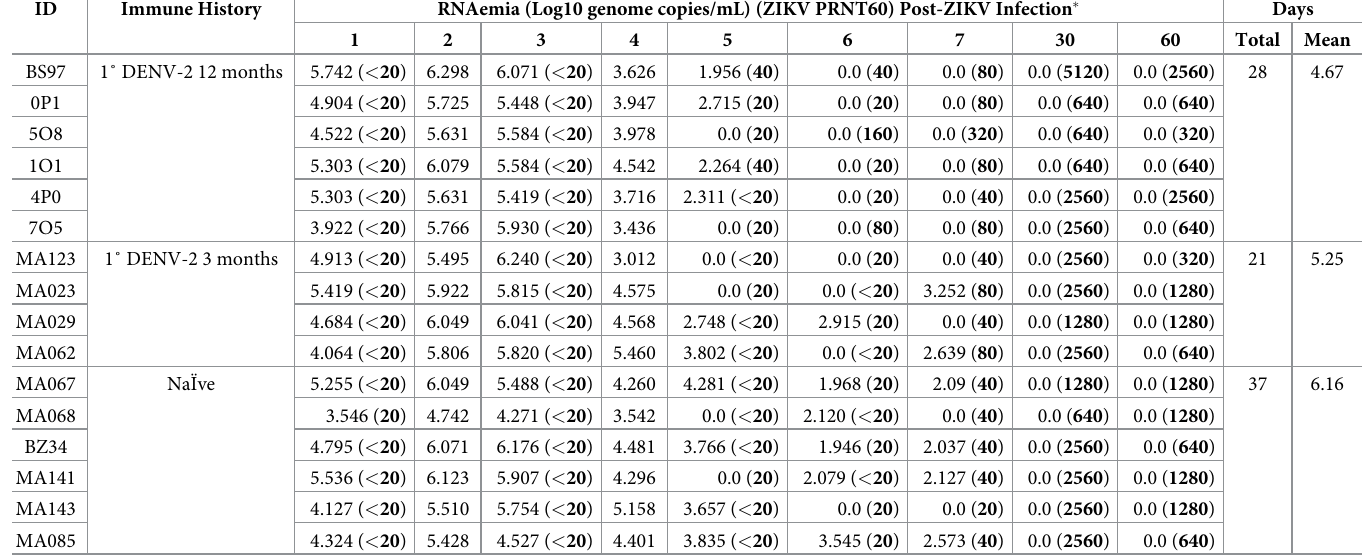
Table 1. ZIKV RNAemia days and neutralizing antibody titers of na ï ve and DENV-immune macaques. ZIKV RNA detection was consistent in all groups during the first 4 days post infection (p.i.). Peak viremia occurred on day 3 p.i. Cohort 1 animals had no detection of ZIKV RNA in serum by day 6 p.i. Mean viremia days per group was calculated using days with detectable RNAemia divided by the number of animals in each group. ID Immune